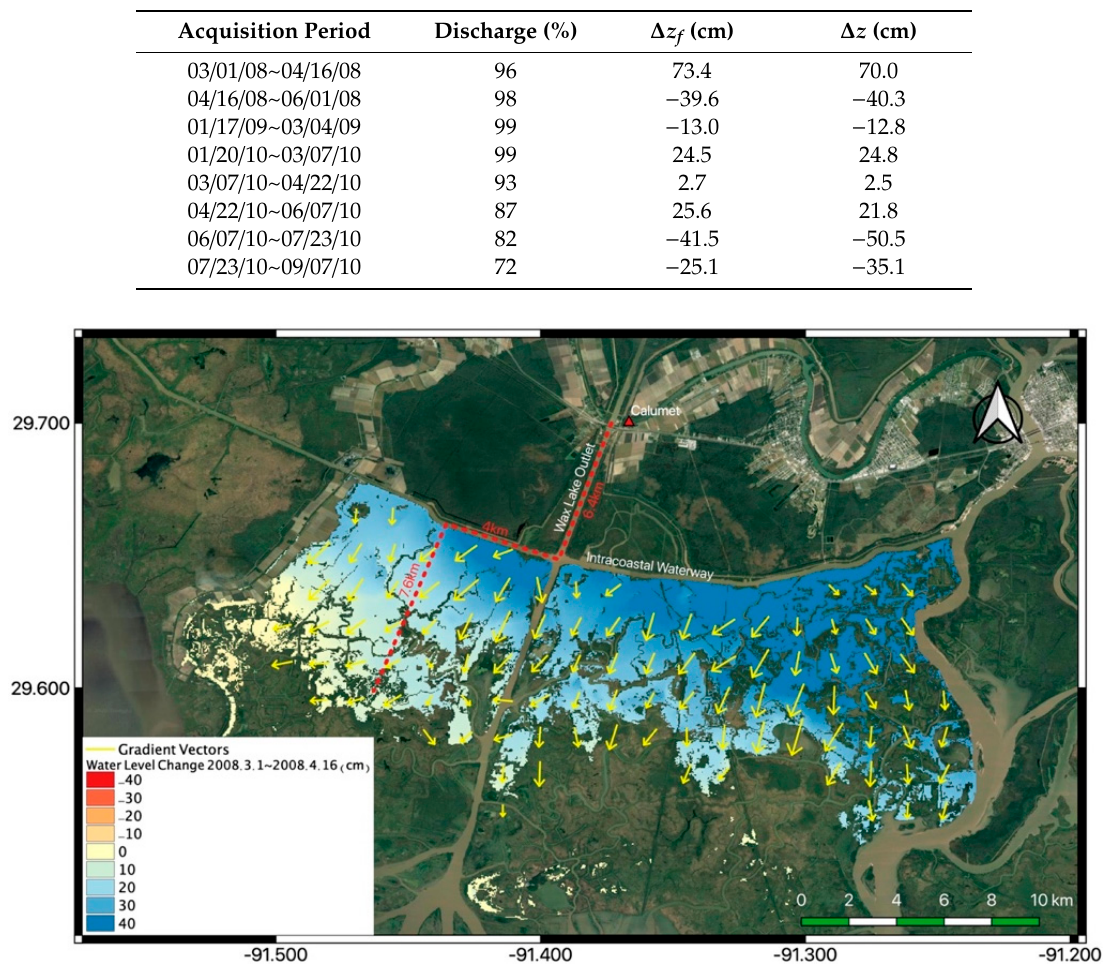
Table 4. Estimation of River Discharge Contribution from Water Level at Calumet.